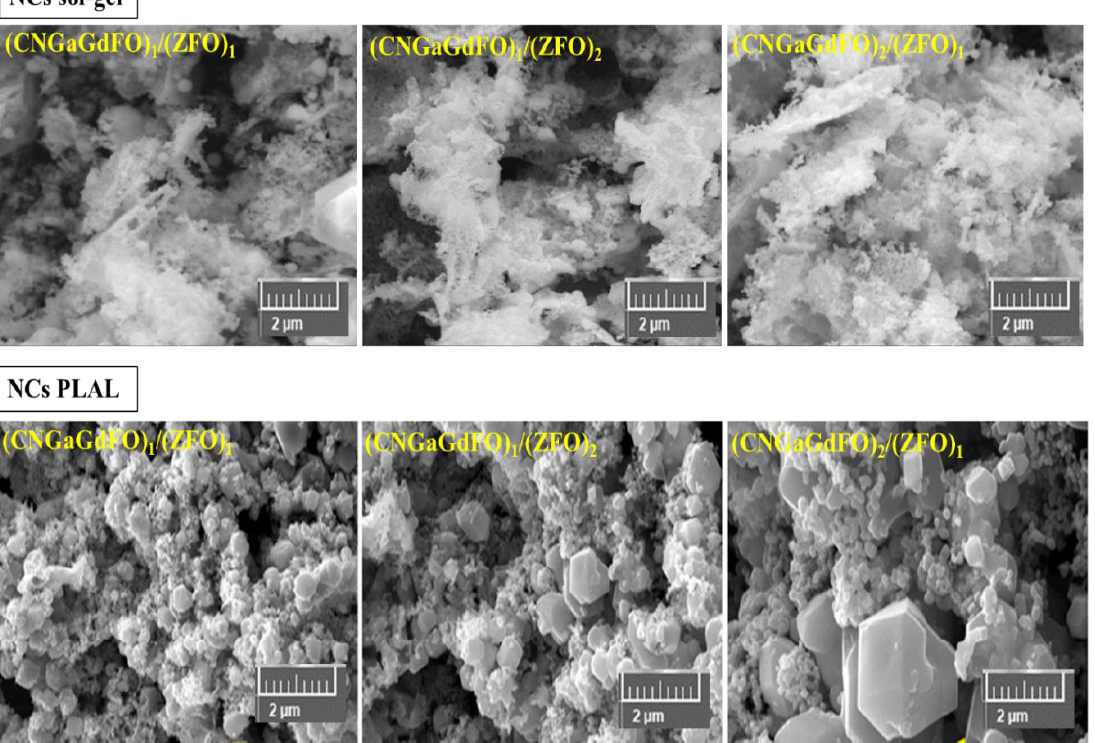
Figure 2. SEM of (CNGaGdFO) x /(ZFO) y ( x:y = 1:1, 1:2 and 2:1) NCs prepared by sol-gel and PLAL.